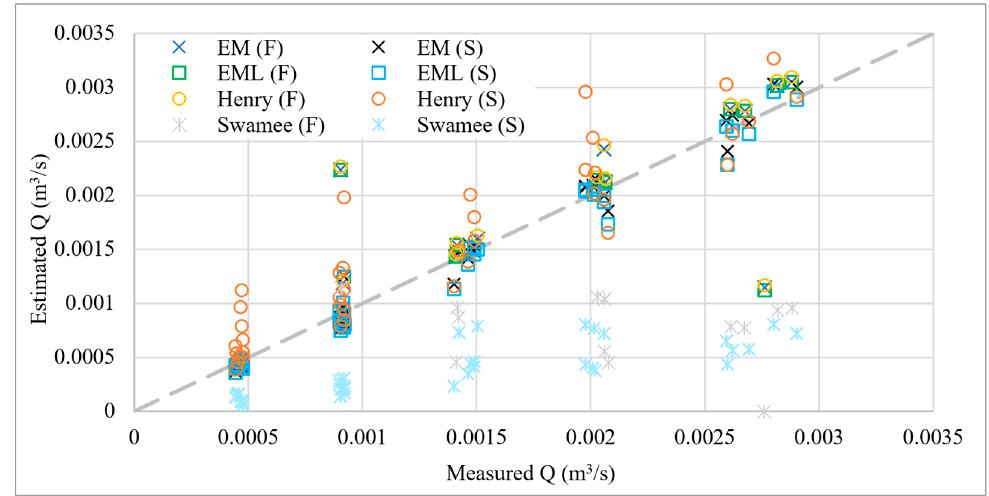
Figure 6. The estimated volumetric flow rate of methods for free and submerged flows. Table 3. The evaluation criteria for estimated flow rates.